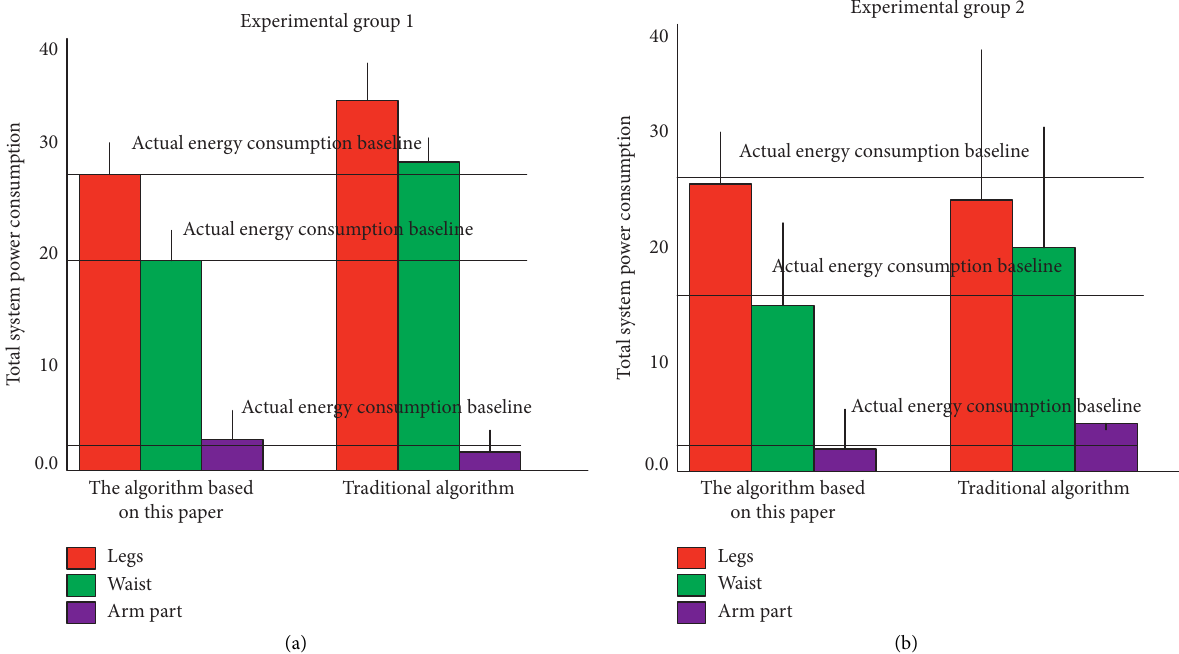
Figure 10: Column chart of motion energy estimation of different parts of the human body of wearable intelligent